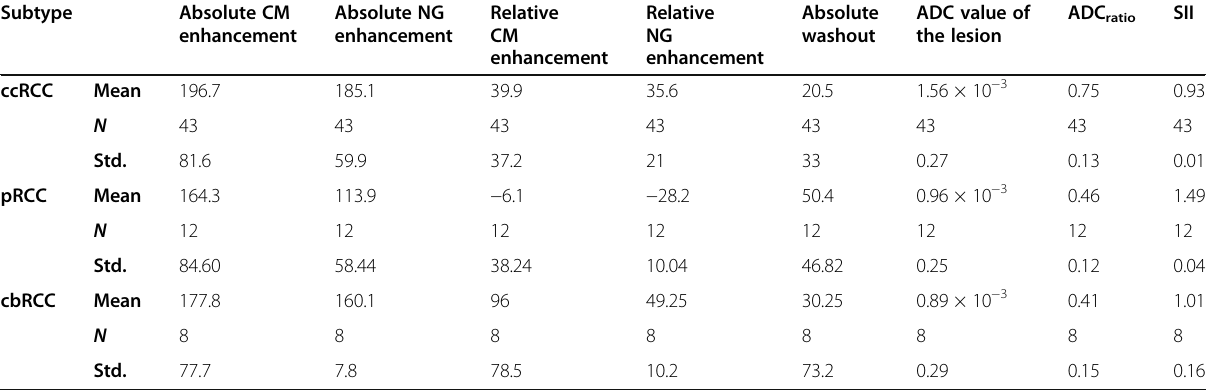
Table 1 Mean values of different quantitative multiparametric MRI parameters in the current study Subtype Absolute CM enhancement